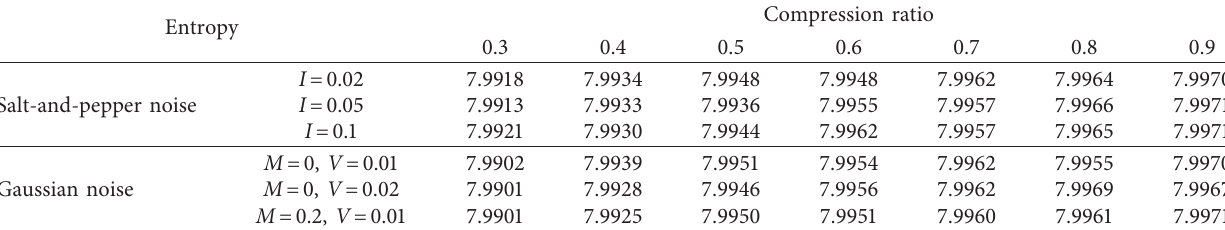
Table 4: Information entropy of encrypted images.